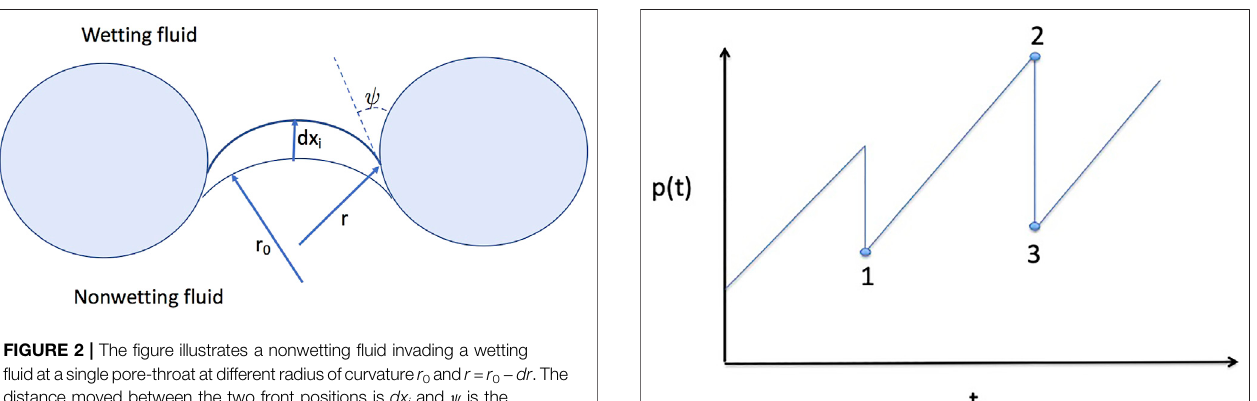
(cid:1) r − dr .The 0 and r 0 FIGURE3| The fi gure illustrates thedependence ofthe pressure across the model p ( t ) and the time t . The front is in equilibrium between point 1 and point 2 and reaches the threshold value of one of the pores along the front at point 2. A burst will appear between point 2 and 3 and the front is there out of